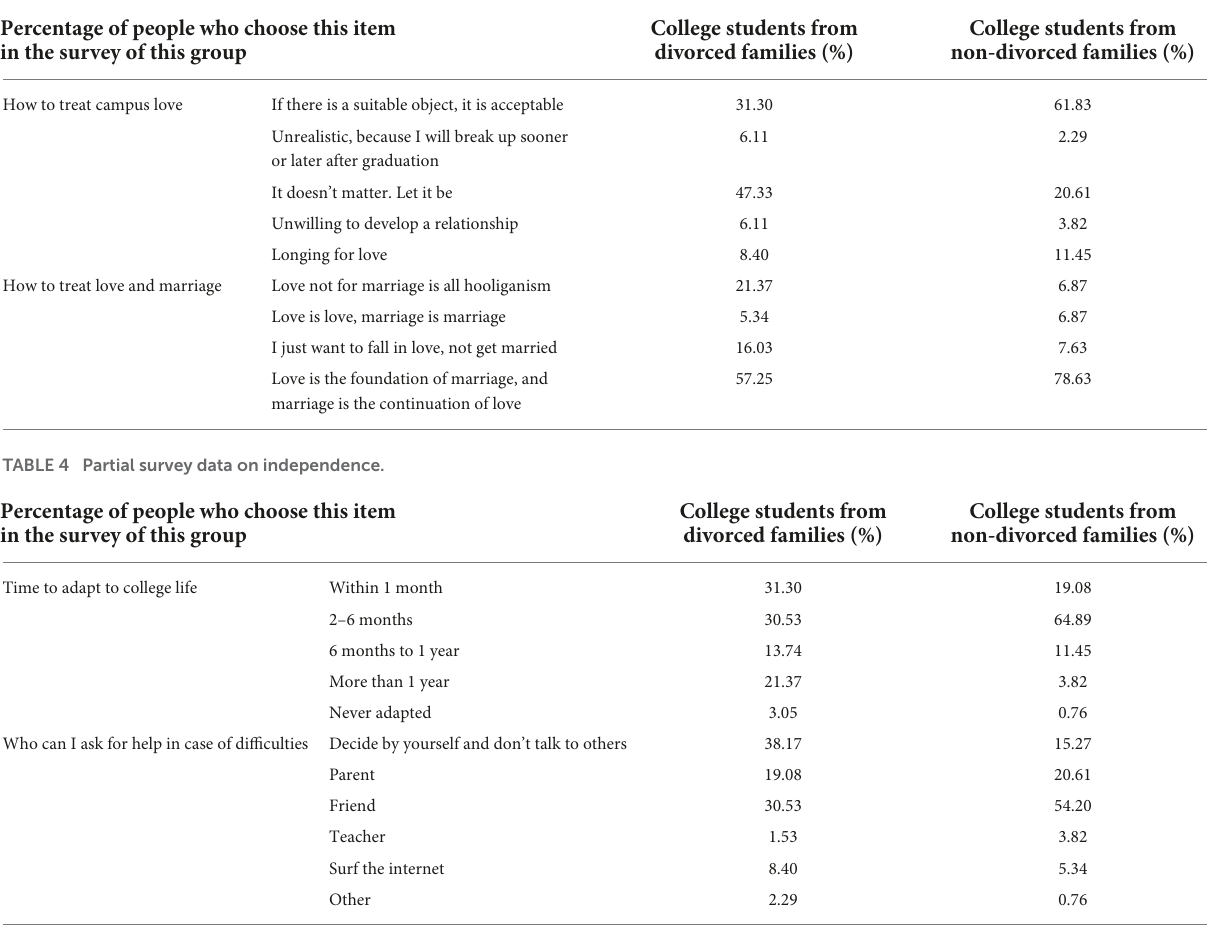
TABLE 3 Survey data on marriage and love.